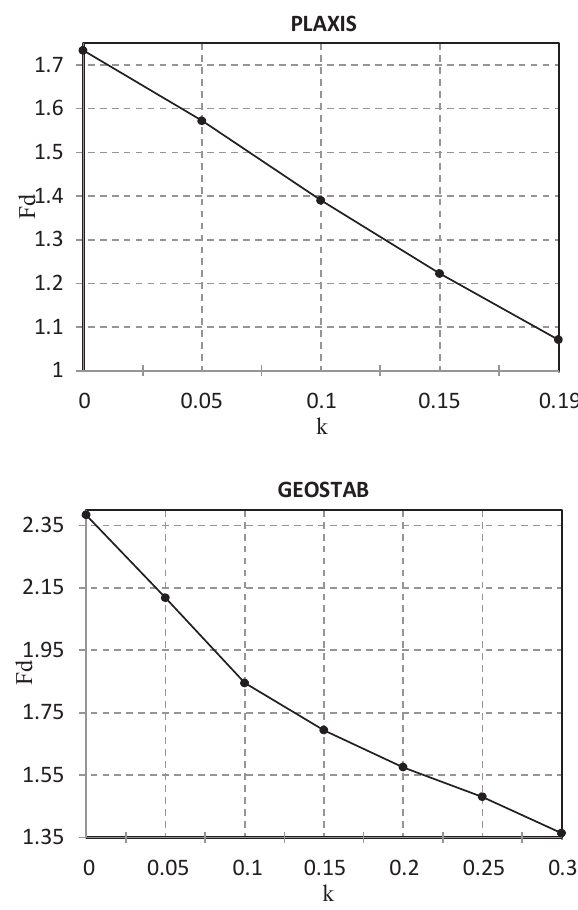
Figure 6: Effect of the seismic coefficient with PLAXIS and GEOSTAB.